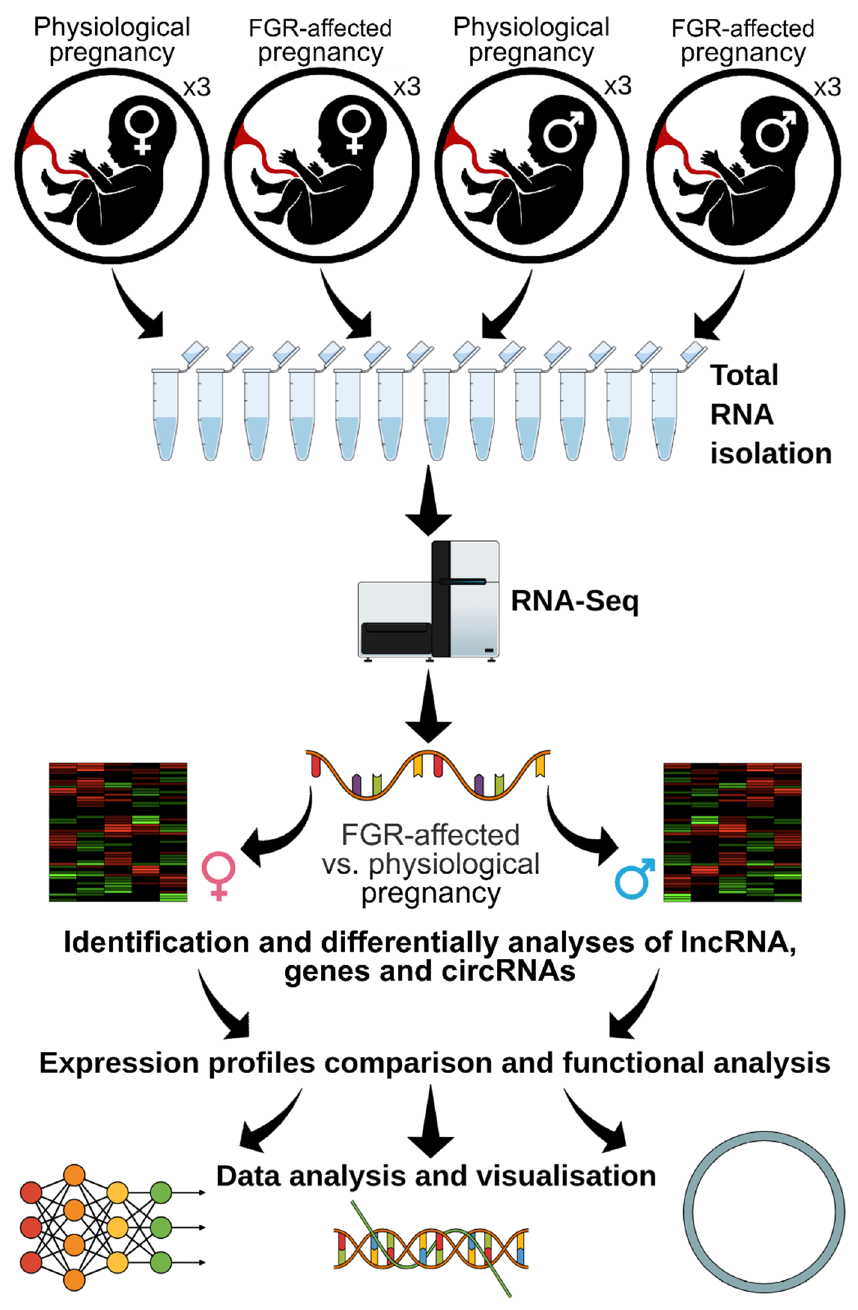
Figure 1. Scheme of the project.